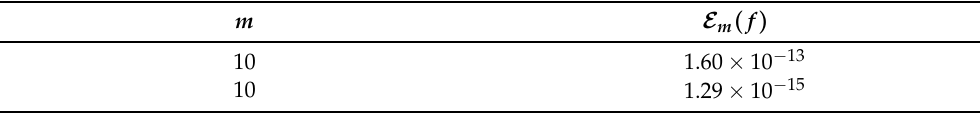
Table 4. Example 3: Errors in rational Gauss rules for approximating (27) with A a symmetric positive definite Toeplitz matrix. In the first row, the poles are α 1 = 0 and α 2 = − 1 of multiplicity two. In the second row, the poles are allocated with (23) with α = − 1 and (cid:96) = 2. This gives the distinct poles α 1 = − 1.1716 and α 2 = − 6.8284 of multiplicity